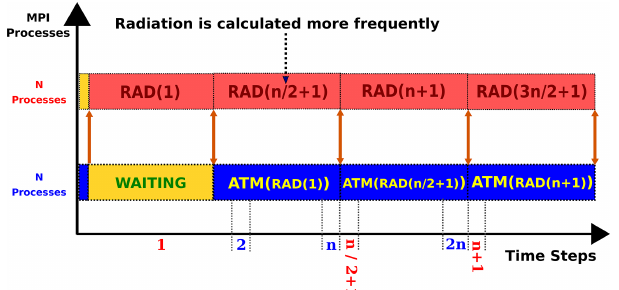
Figure 13. A model configuration for assigning coarser domain de- composition to the radiation calculations. This setup allows for allo- cating a lower number of MPI processes to the radiation component and hence improves the parallel efficiency of the